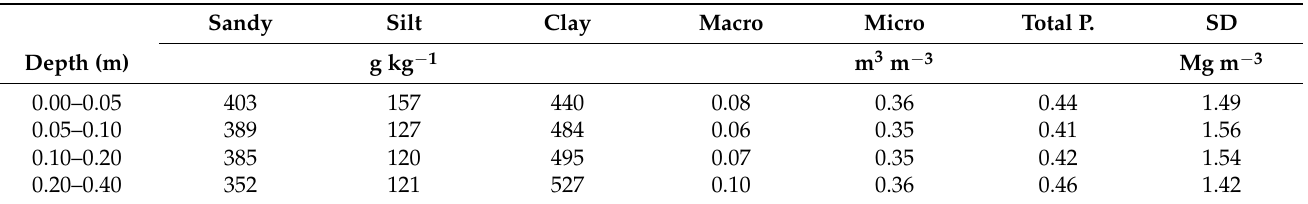
Table 1. Physical attributes of the soil at different depths of the experimental area, before the installation of the experiment. Selv í ria, Brazil, 2012. Sandy Silt Clay Macro Micro Total P.